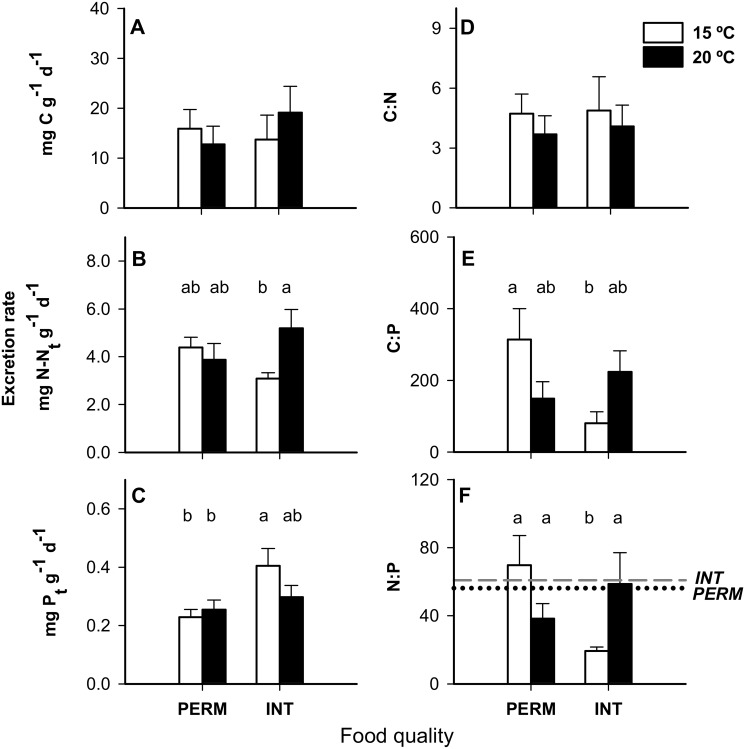
Relative excretion rate (A-C) and molar ratios in excreta (D-F) of E. berilloni (n = 11–15) maintained at 15 and 20°C and fed PERM and INT leaves.The results are the mean (± SE) for the different treatments. The horizontal lines represent molar ratios of leaves conditioned under PERM (gray dashed line) and INT (black dotted line) conditions. The C:N and C:P ratios of leaves fell above the range of the graphs. Different letters indicate significant differences based on independent pairwise comparisons adjusted by the Dunn-Sidak correction at α = 0.05.